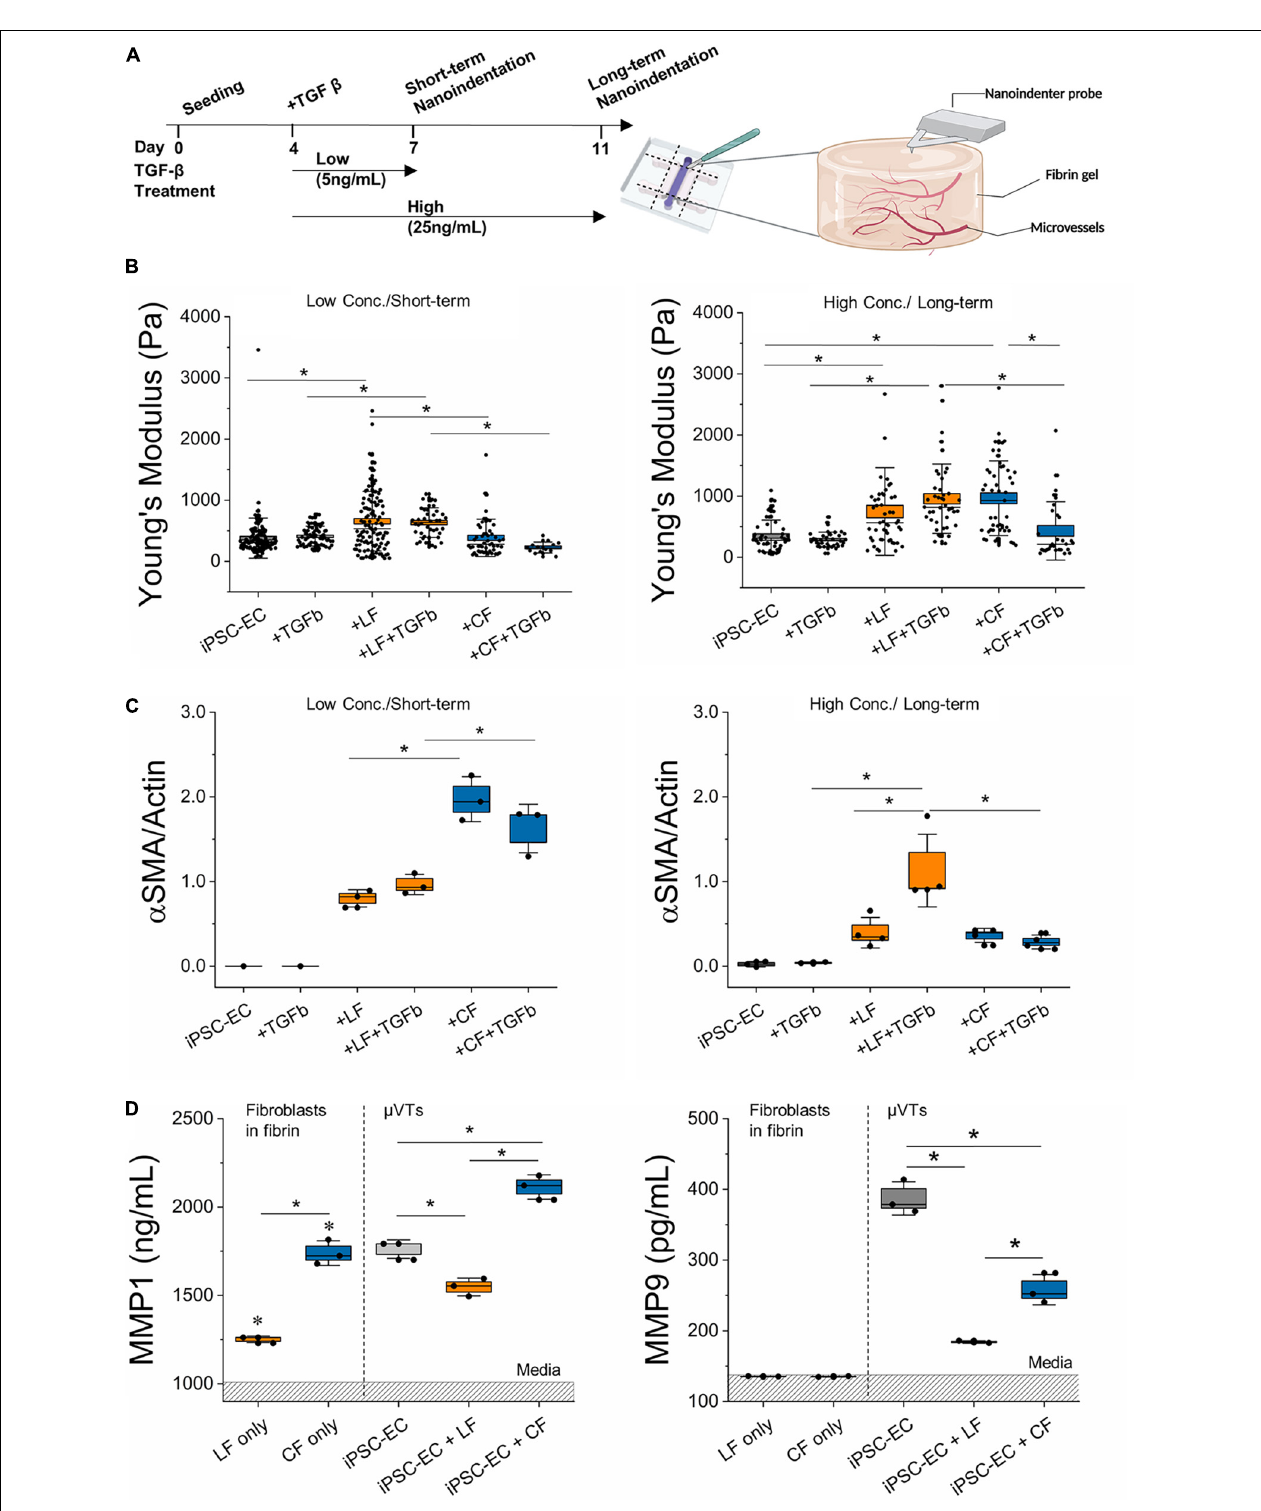
FIGURE 4 | TGF- β treatment induces differential stromal-cell matrix remodeling. (A) Schematic diagram of TGF- β treatment regimens and subsequent nanoindentation experiments. (B) Measured effective Young’s modulus of the microvessels for the low concentration/short-term and high concentration/long-term conditions. (C) Relative α SMA expression in the different treatment regimens determined by Western Blot (for iPSC-EC low conc./short-term n = 3 samples were pooled). (D) MMP 1 and MMP 9 expressed in TGF- β treated microvascular tissues measured by ELISA. Dashed region is the mean value for media. Significance is shown by * P < 0.05, using a one-way ANOVA and a subsequent Tukey means comparison test. Box plots demonstrate SD (outer whiskers) and SE (box edge).